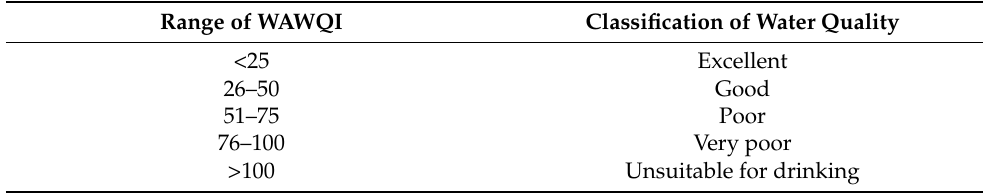
Table 2. Classification of Weighted Arithmetic Water Quality Index.